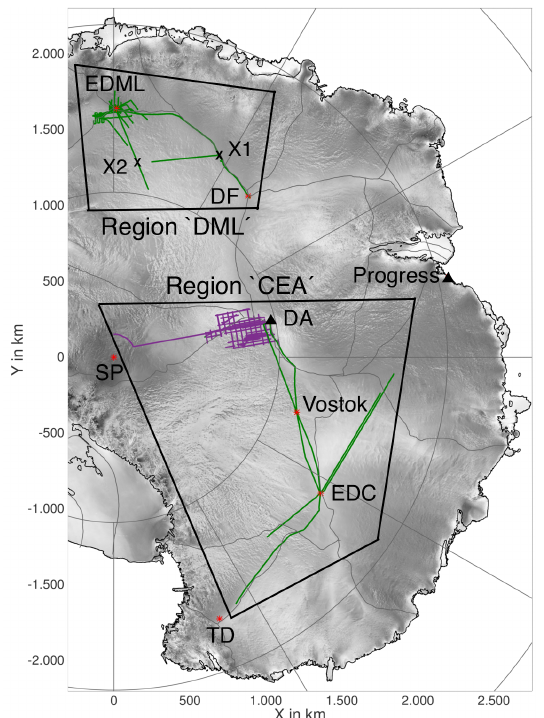
Figure 1. Overview of East Antarctica with the RES profiles along which we continuously traced IRHs (green lines: AWI data, pur- ple lines: AGAP-South data) and deep drill sites, stations and other locations mentioned in the text. Abbreviations of sites of interest are listed as follows: EPICA Dronning Maud Land (EDML), Dome Fuji (DF), Dome Argus (DA), South Pole (SP), EPICA Dome Con- cordia (EDC) and Talos Dome (TD). Gray lines indicate the ice divides (Zwally et al., 2012), coordinates are polar stereographic